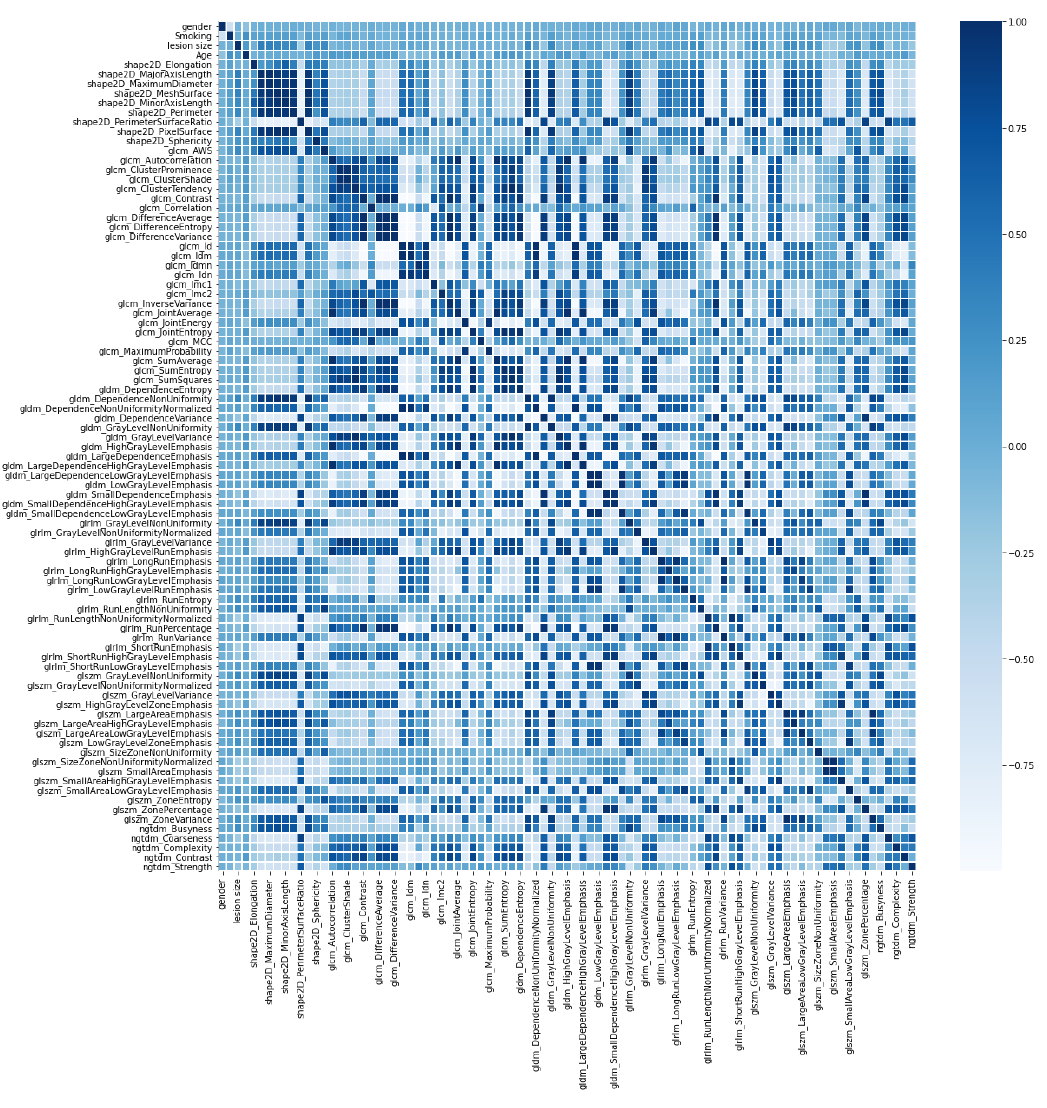
Figure 5. Heat map of Pearson correlation coefficient matrix for all features.